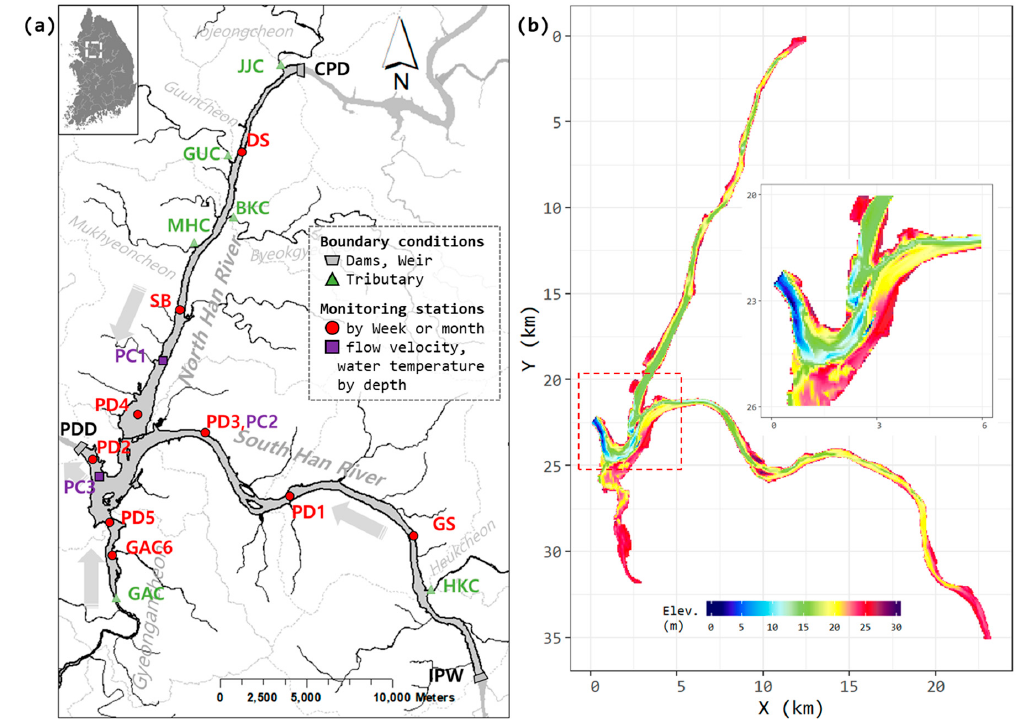
Figure 1. Boundary conditions and monitoring sites of ( a ) Paldang reservoir and its ( b ) bathymetry. Elev. means elevation above mean sea level.